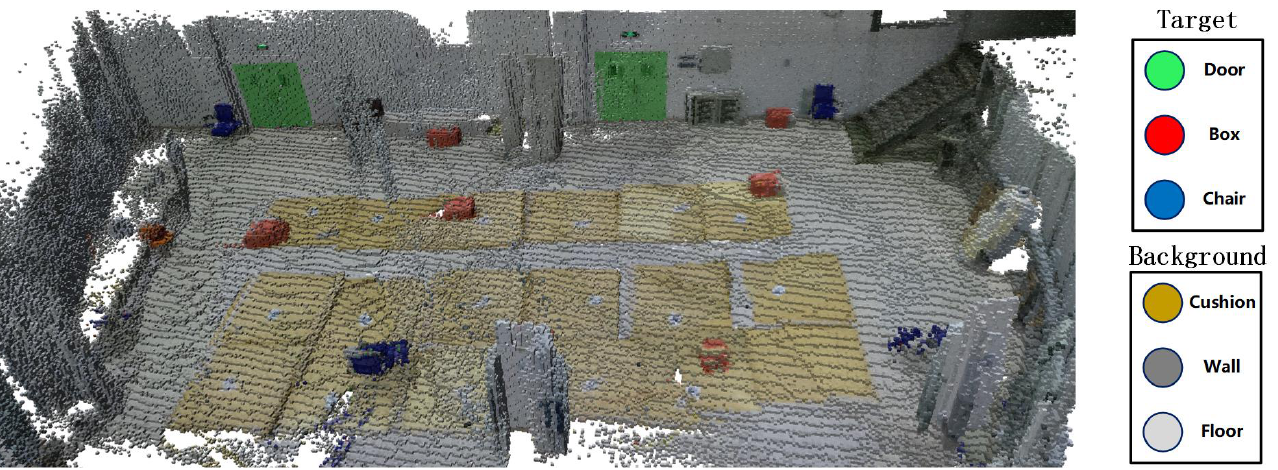
Figure 11. Processing steps and results for the proposed RTSDM. The input images in ( a ) were acquired by the camera and entered into the system for 2D semantic segmentation as shown in ( b ), the semantic information was superimposed on the input images as shown in ( c ), then the system built the local 3D maps of the input images as shown in ( d ). Finally, the 3D semantic mapping result over the experimental site as shown in ( e ) was obtained by stitching the pose